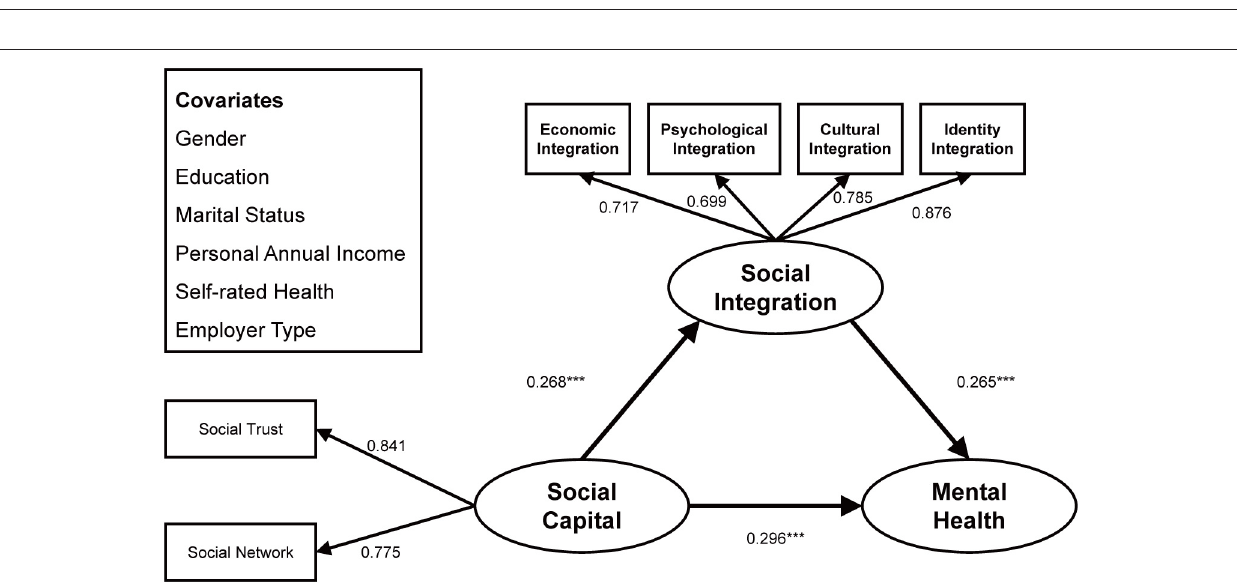
FIGURE 4 | Standardized structural model (sub-sample: 31–50 years old). *** p <